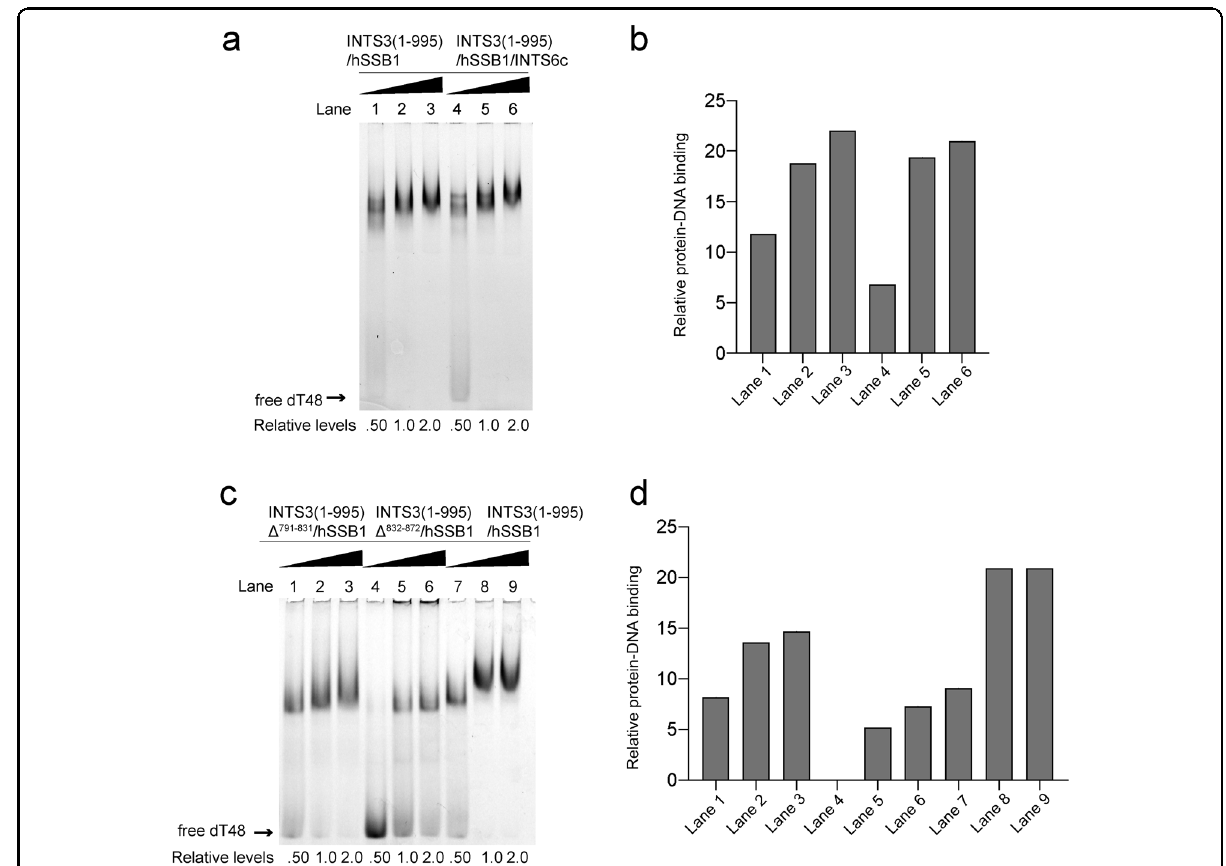
Fig. 5 Interaction of hSSB1 and other INTS3/hSSB1 complexes with ssDNA. a Interaction of dT48 with INTS3 (1 − 995)/hSSB1 and INTS3 (1 − 995)/ hSSB1/INTS6c as examined by electrophoretic mobility assay (EMSA). b Quanti fi cation of relative protein − DNA binding in a . c Interaction of dT48 with INTS3 (1 − 995) Δ 791 − 831 /hSSB1, INTS3 (1 − 995) Δ 832 − 872 /hSSB1 and INTS3 (1 − 995)/hSSB1 as examined by electrophoretic mobility assay (EMSA). d Quanti fi cation of relative protein − DNA binding ( c